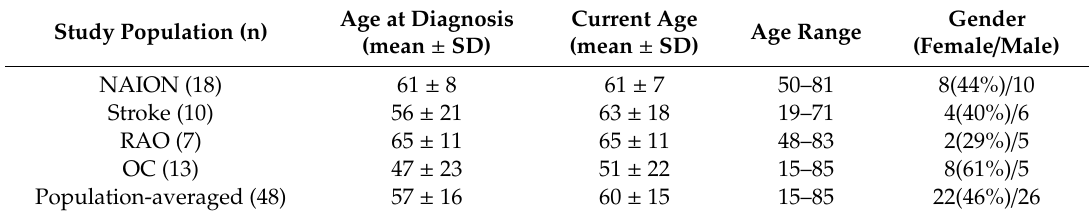
Table 1. Demographic characteristics of